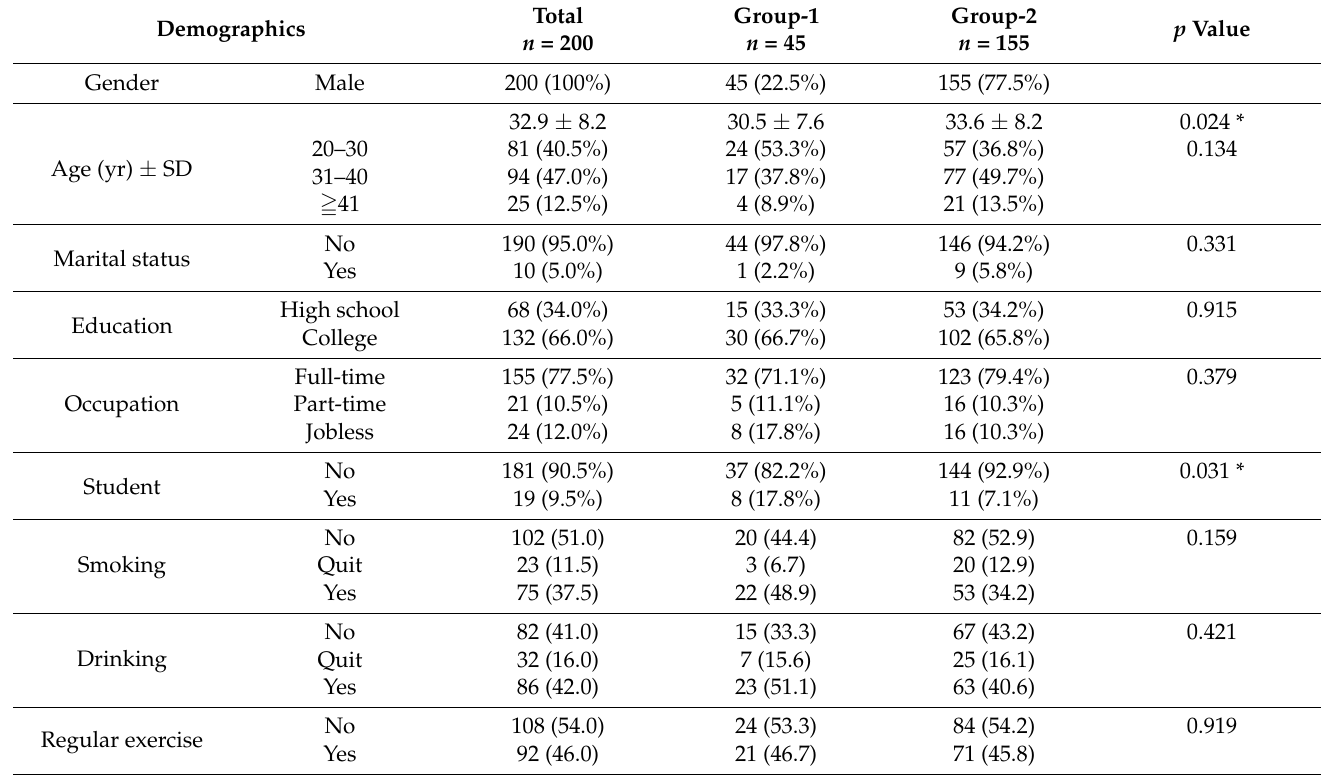
Table 1. Characteristics of HIV-infected patients ( n =